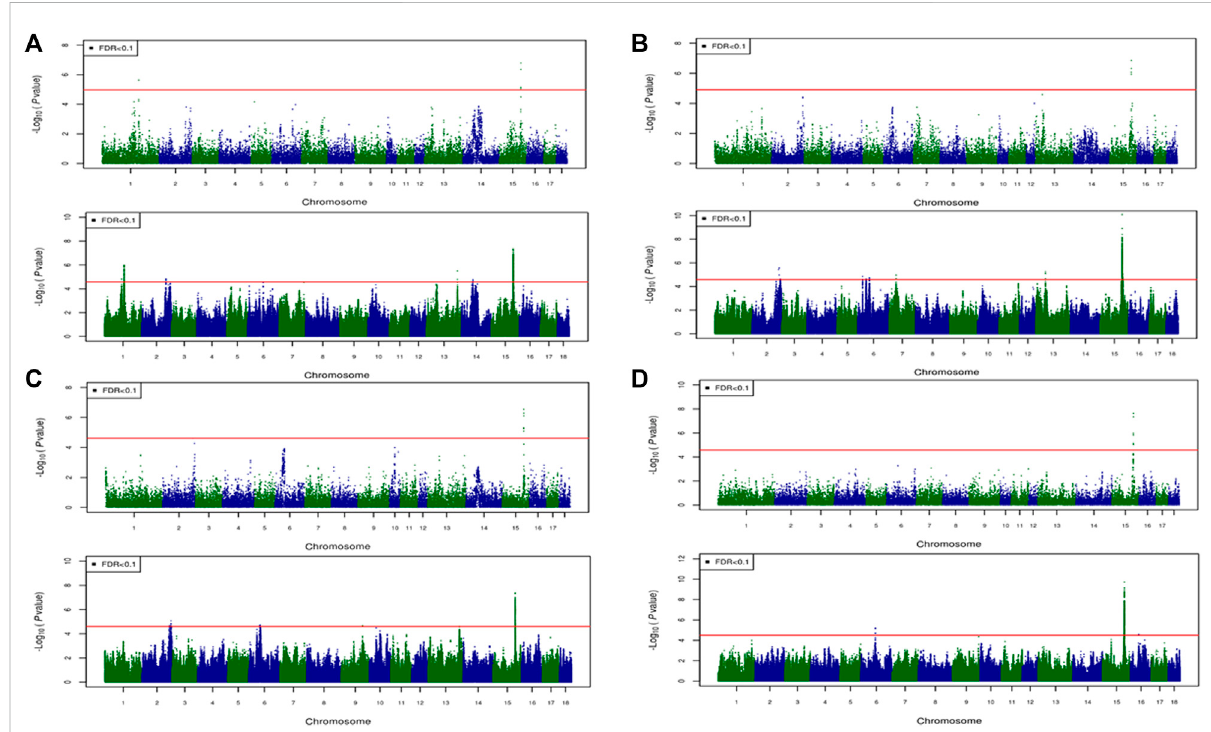
FIGURE 6 Associated regions detected byGWAS for combined crossbred and purebred pigs. Manhattan plots for: (A) FMCOLA (B) FMCOLB (C) GMCOLB, and (D) ICOLB using a combined (61K + 50K) medium-density panel (top Figure) and WGS (bottom Figure). The -log10 p -values of single-SNP association along the entire genome are plotted against the genomic position of SNPs along the 18 autosome chromosomes. The SNPs associated with the corresponding traits exceeded the signi fi cance threshold at false discovery rate (FDR) of 0.1, having signi fi cant effects.